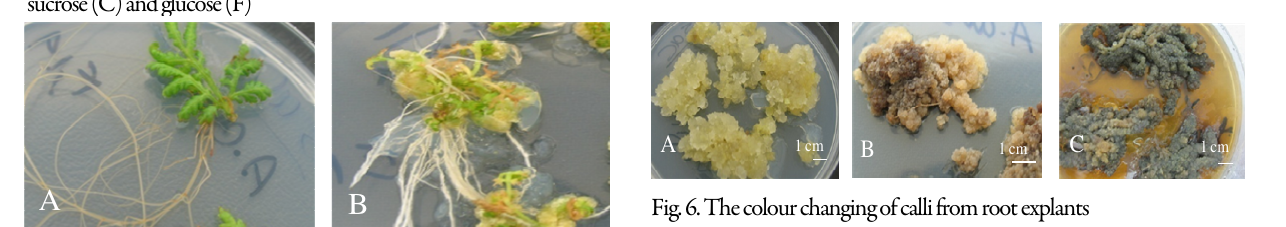
Fig. 6. The colour changing of calli from root explants (A) The white calli in 7 th day; (B) Browning of calli because of the phenol released in medium culture due to the delay in subculturing at 14 th day and 30 th day